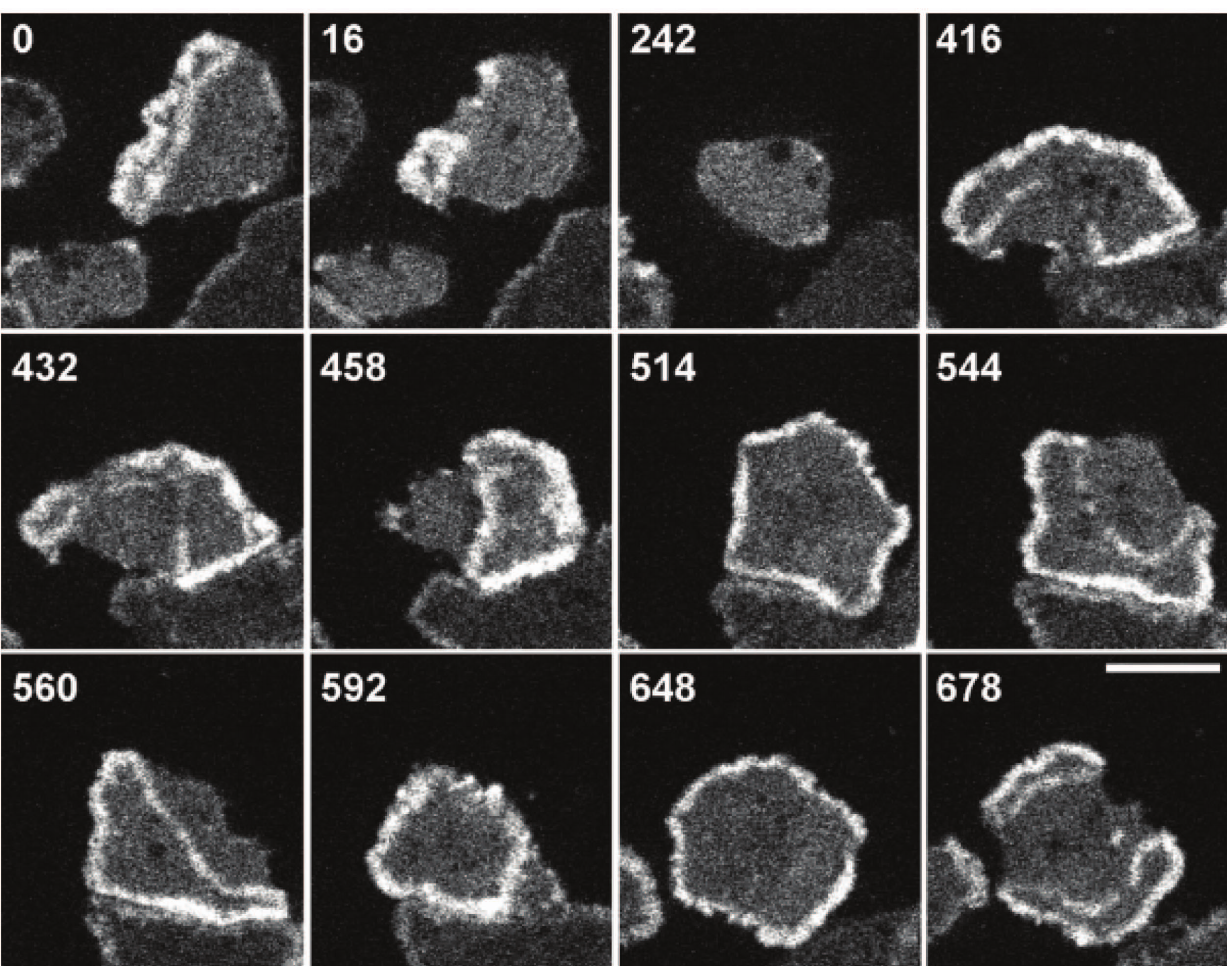
Figure 1. Actin waves in normal and LatA-treated cells. Evolution of actin waves in a LatA-treated cell imaged by TIRF displays expansion, retraction, separation, and collapse of the waves. The cell comes in contact with another cell between 416 s and 592 s [25].